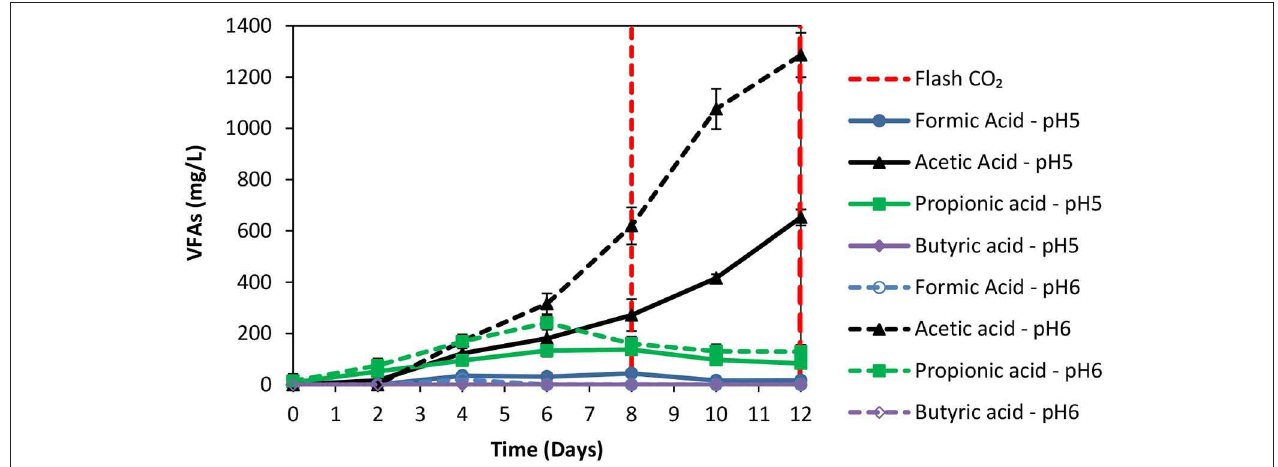
FIGURE 4 | VFAs production over time over time for anaerobic granular sludge that was pre-heated and then exposed to 100 g/L ZVI and operated at pH 5–6 and pH 6–6.5, respectively.